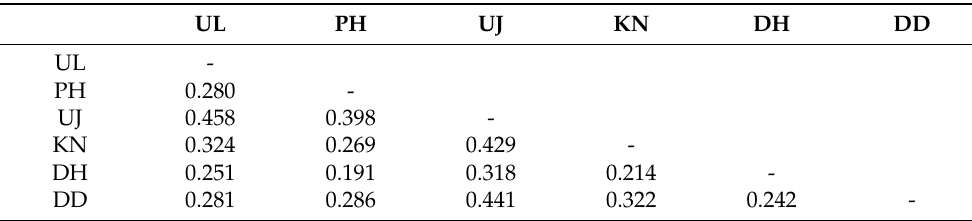
Table 2. Mean pairwise F ST values were computed from 4042 SNPs among 6 populations of Rattus norvegicus on the east coast with Ulleung and Dok-do islands, Republic of Korea. See Table 1 for the population abbreviations. All values are statistically significant at p < 0.01.